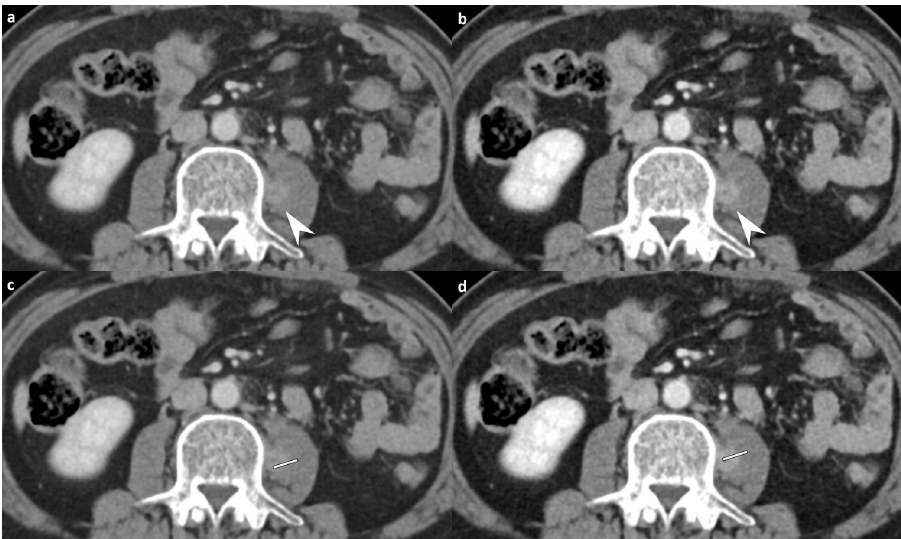
Fig 4. Contrast-enhanced abdomen CT in the portal venous phase in a 45-year-old man (body mass index, 24.8 kg/m 2 ) with sigmoid colon cancer with a seeding nodule in the left psoas muscle. 80/Sn150 kVp CT (a-b, effective dose; 4.5 mSv) showing a hyperattenuating mass in the left psoas muscle (white arrows) by each reader (reader 1 and reader 2, grade 4 lesion conspicuity, grade 5 diagnostic confidence, and grade 5 overall image quality). The corresponding image obtained during the identical phase with 80 kVp CT (effective dose; 2.6 mSv) demonstrates markedly increased conspicuity of the lesion in the left psoas muscle by each reader (reader 1 and reader 2, grade 5 lesion conspicuity, grade 5 diagnostic confidence, and grade 5 overall image quality). Modified line-density profile revealed higher attenuation differences between the tumor and the normal tissue at 80 kVp (d) than those at 80/Sn150 CT (c) (maximum HU: minimum HU, 129:27 vs.106:36). CT, computed tomography.